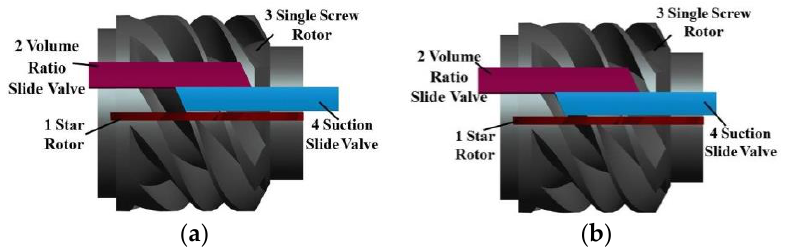
Figure 2. Structural diagram of slide valves. ( a ) Slide valves at the designed position. ( b ) slide valves at the position of decreased suction closure volume/discharge opening volume.